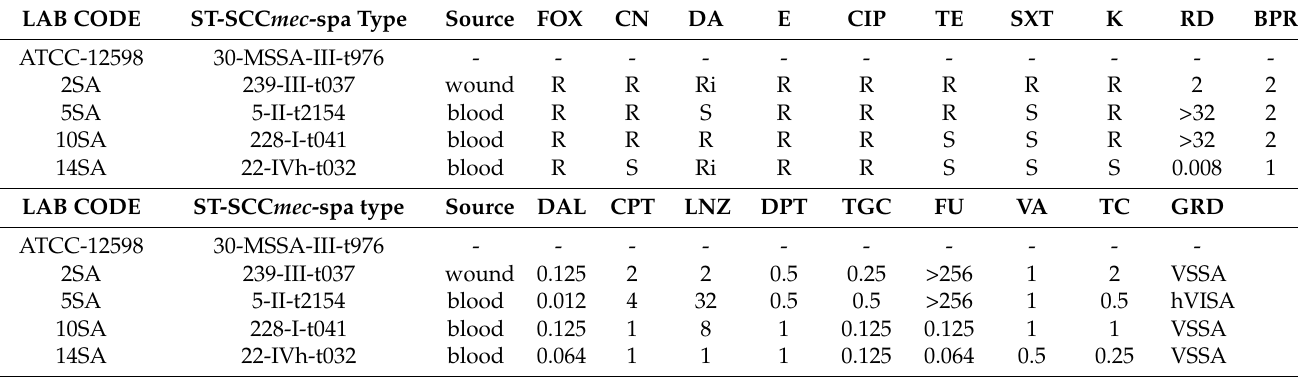
Table 1. Phenotypical and molecular characteristics of the five different S. aureus strains included in the study. LAB